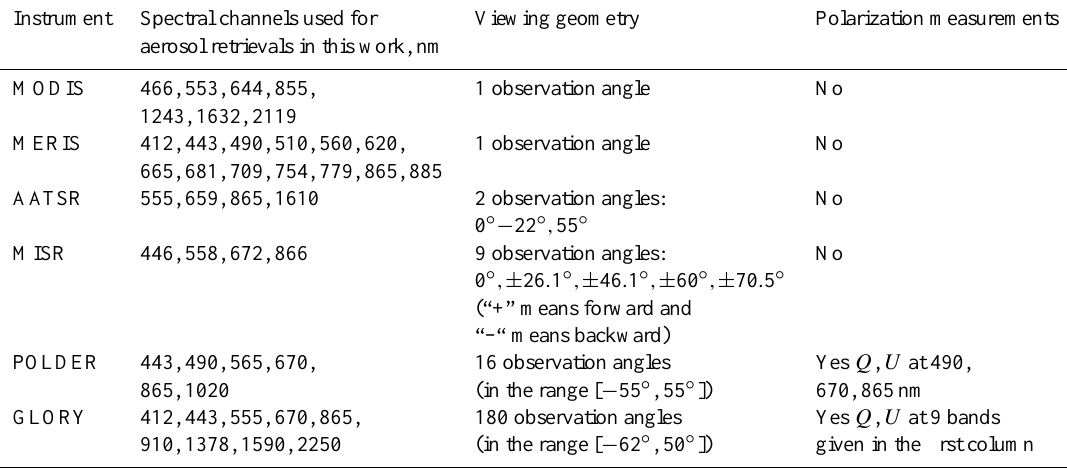
Table 1. The capabilities of modern satellite instruments for aerosol remote sensing. Instrument Spectral channels used for Viewing geometry Polarization